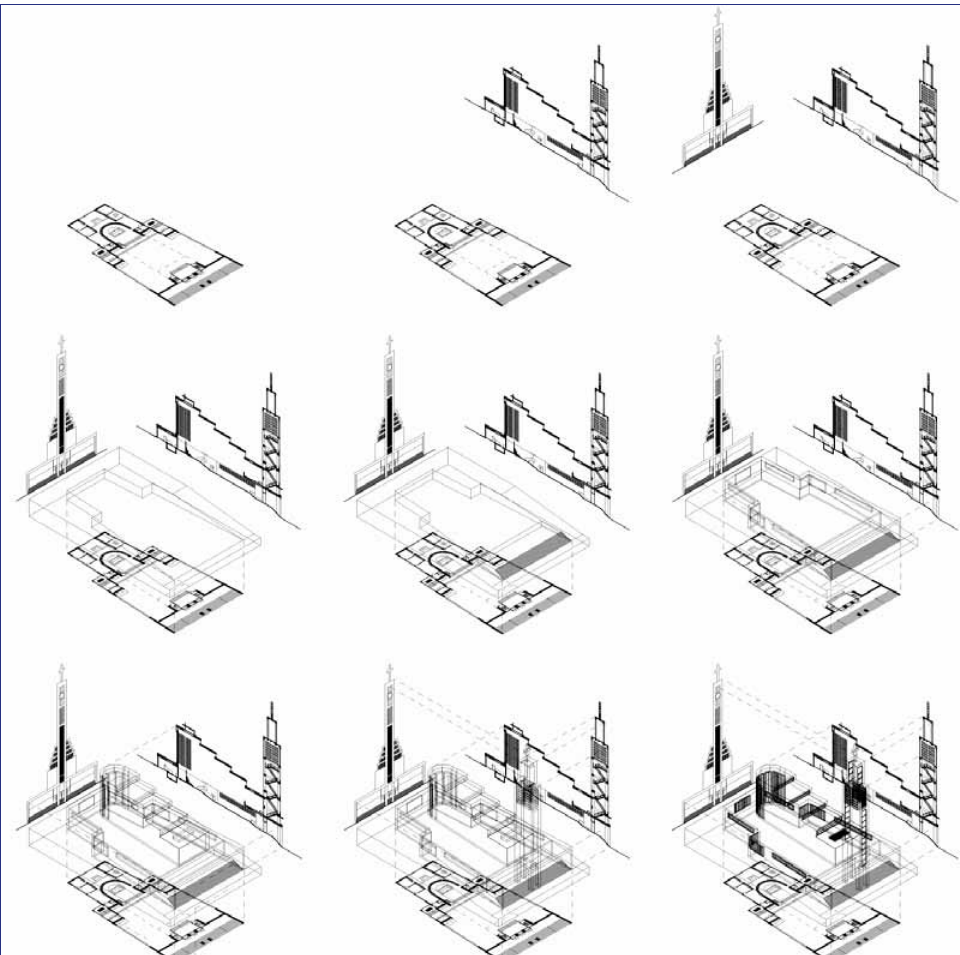
fig. 2. j. Gočár, Church of Saint Wenceslas in Prague, Vršovice, 1928–1929